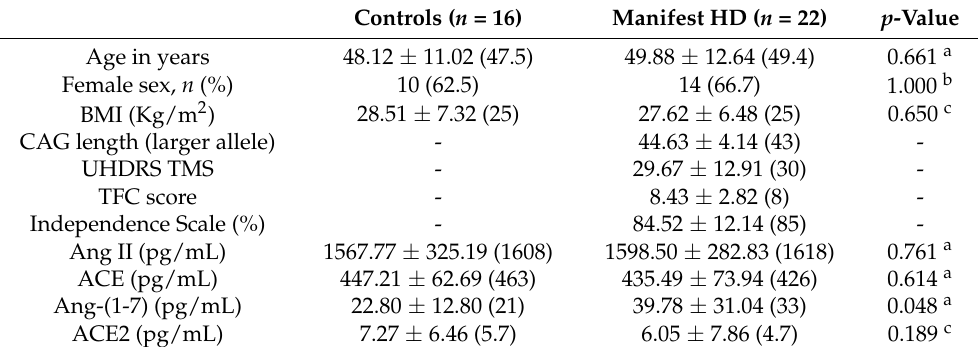
Table 1. Demographic and clinical data of patients with HD and controls.